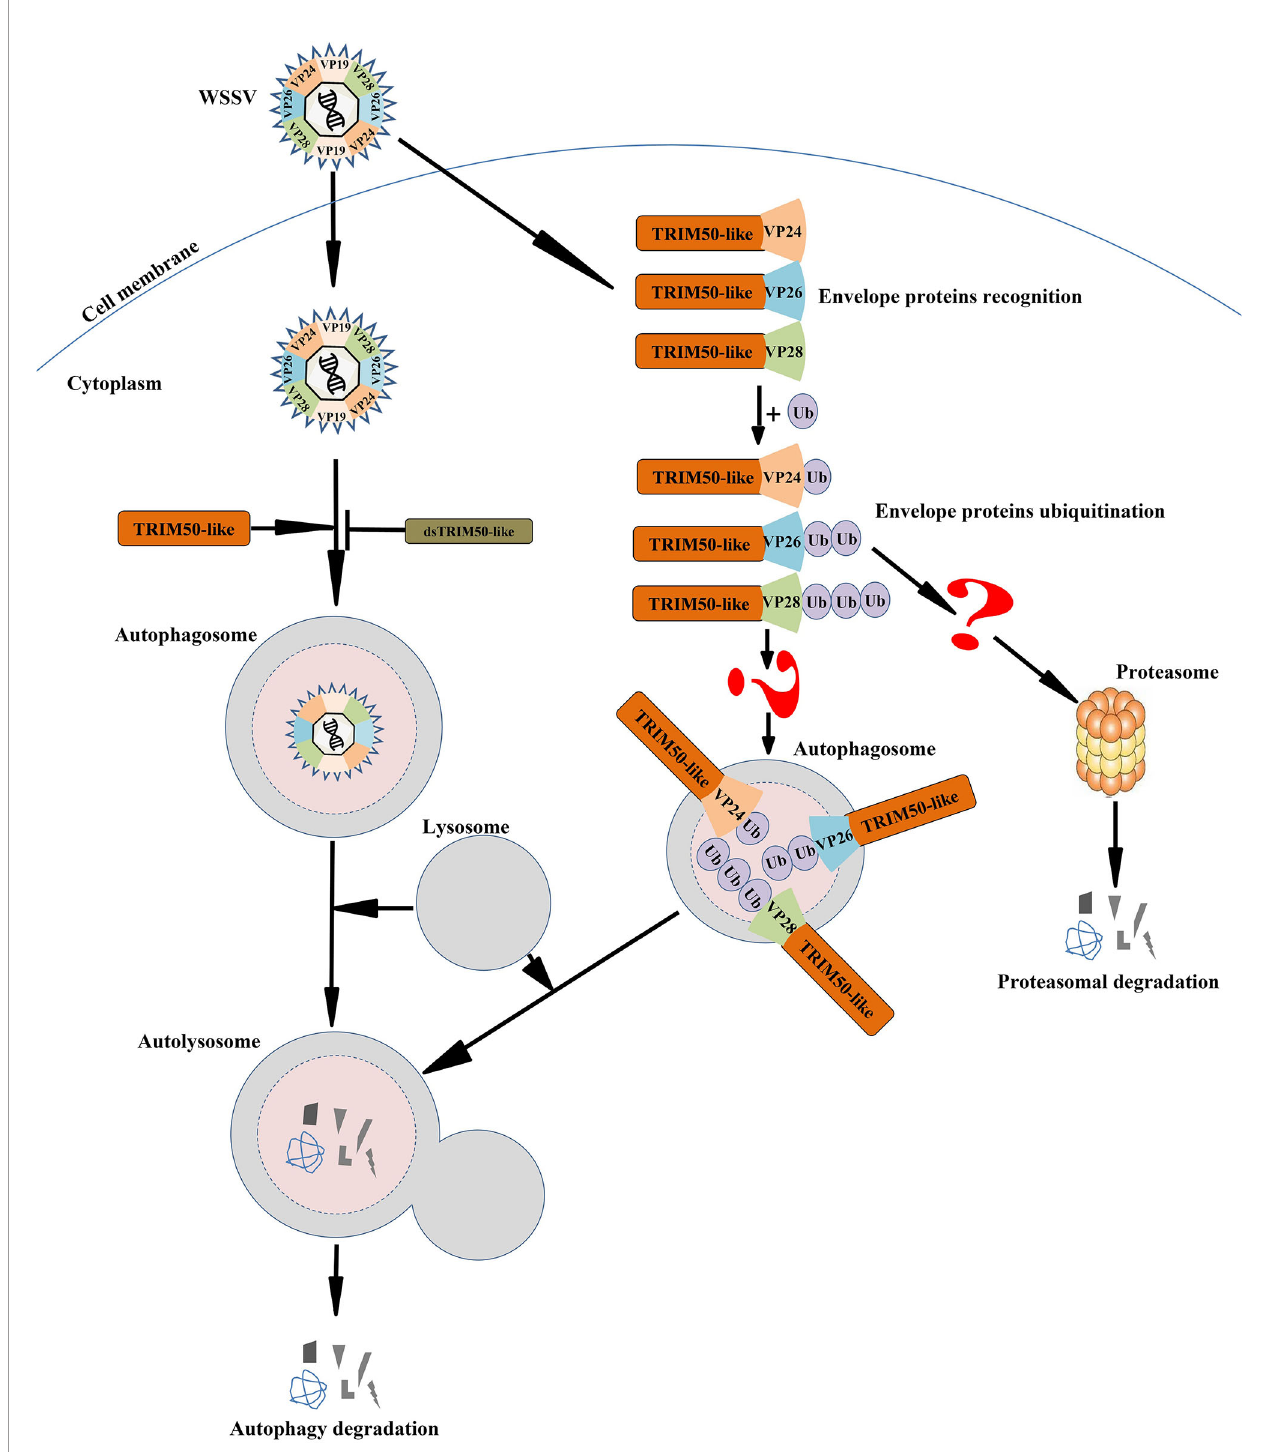
FIGURE 7 | Predicted schematic diagram for PmTRIM50-like-mediated anti-WSSV autophagy in shrimp. After WSSV infection, the expression of PmTRIM50-like was upregulated and autophagy was induced in shrimp. Subsequently, autophagy degraded WSSV in a PmTRIM50-like-dependent manner. In shrimp cells, PmTRIM50-like might act as a cargo receptor to recognize and ubiquitinate WSSV envelope proteins of VP24, VP26, and VP28. The recognition and ubiquitination might mark and target WSSV for degradation by